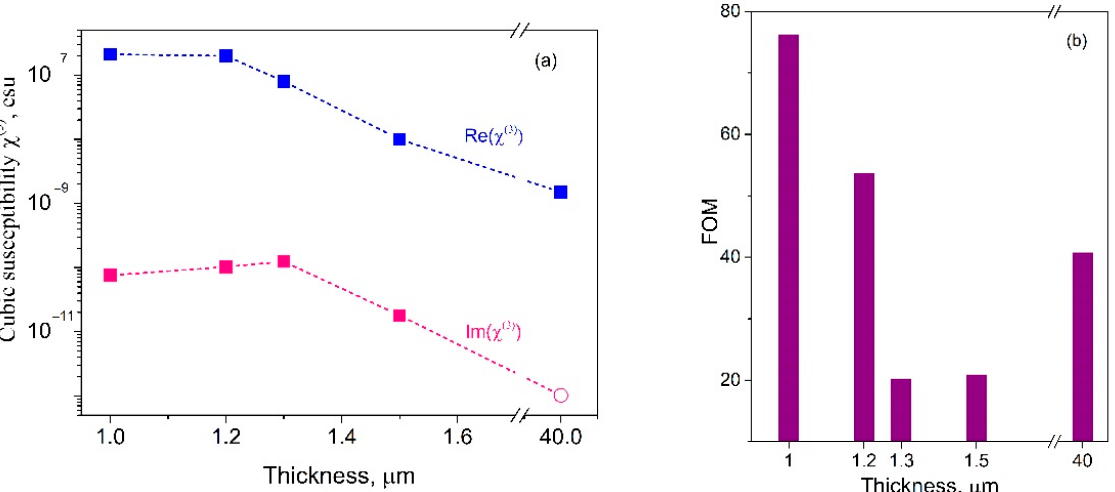
Figure 4. ( a ) Comparison of real Re( χ (3) ) and imaginary Im( χ (3) ) parts of cubic NLO susceptibility vs. thickness for coating films under picosecond laser excitation at 1064 nm. The red circle point corresponds to the absolute values of Im( χ (3) ) for the sample № 5 (see Table 1); ( b ) Variation of FOM vs. samples thickness.